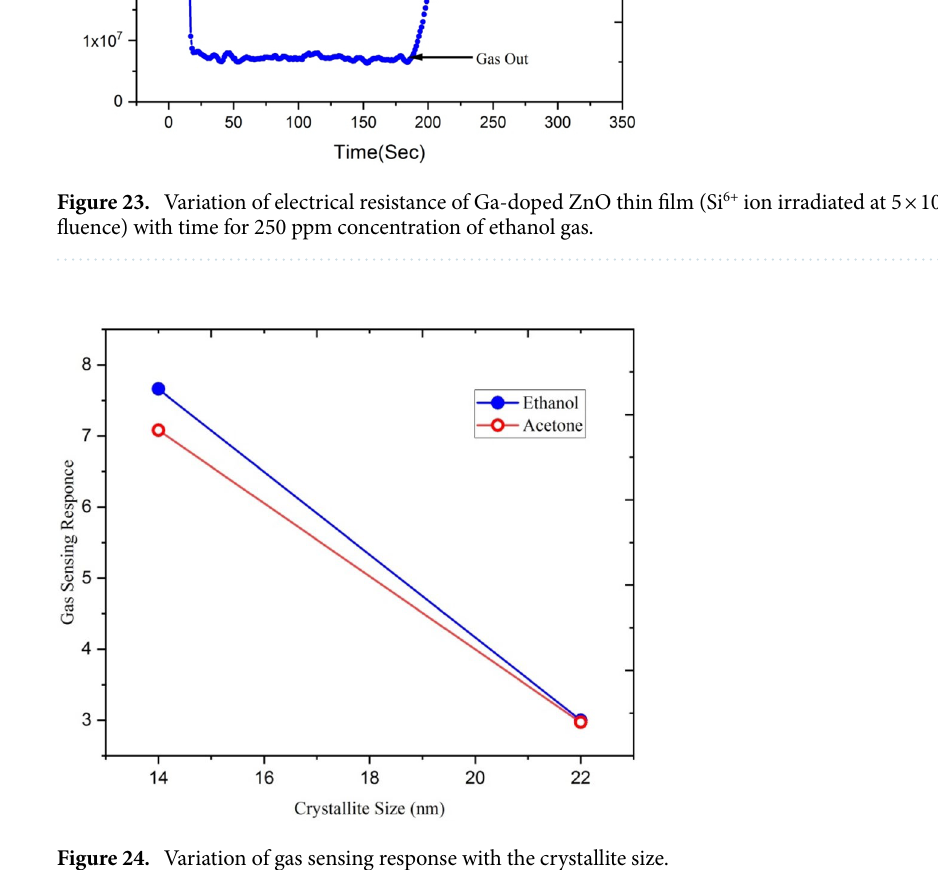
Figure 24. Variation of gas sensing response with the crystallite